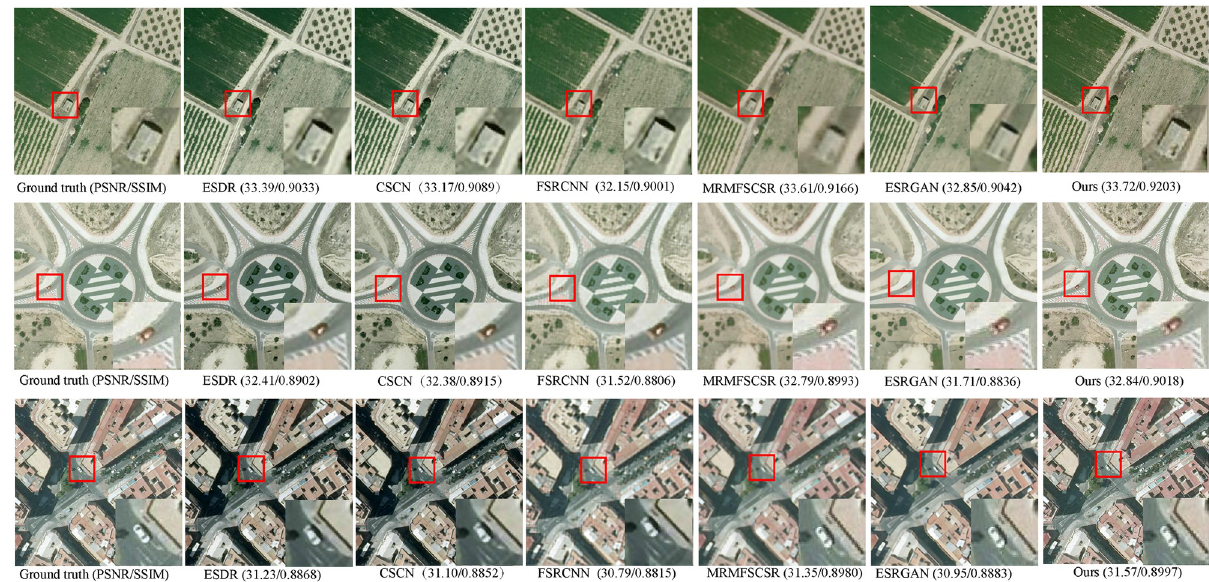
Fig 5. The comparative results of Test20 dataset magnified by an up-scaling factor 3.